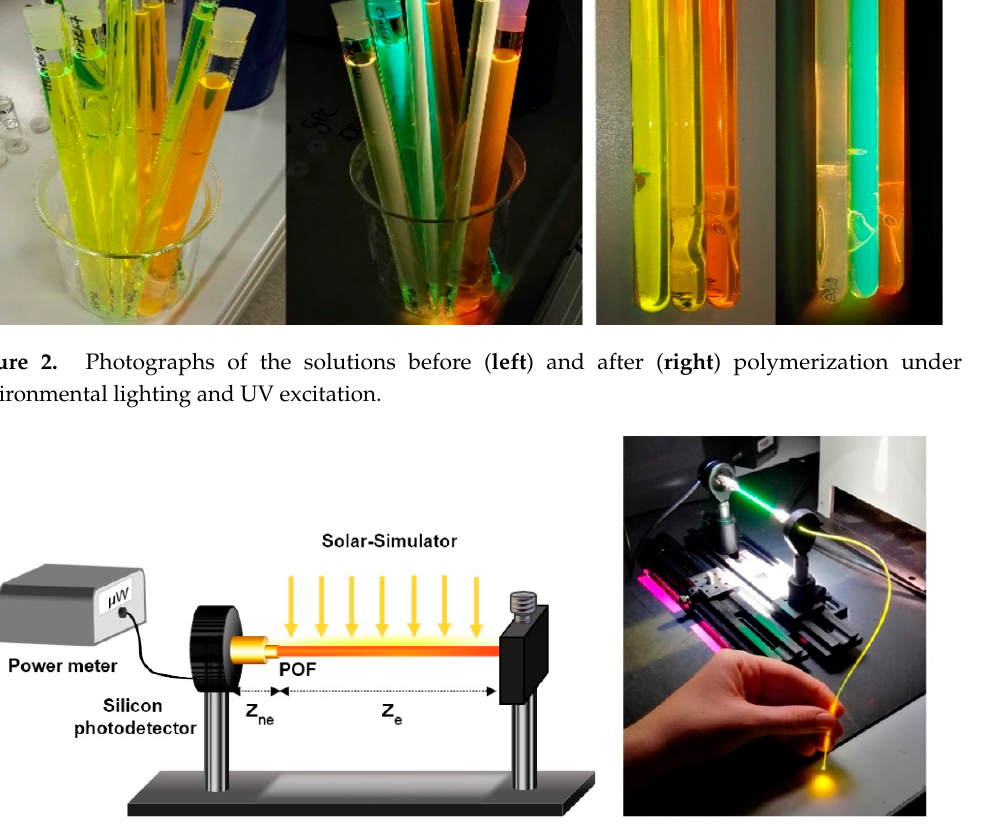
Figure 3. Schematic of the experimental set-up employed for the characterization under solar simulator ( left ). z e represents the illuminated fiber length, and z ne is the non-excited fiber length up to the detector; photograph of one of the fibers in the set-up under solar simulator excitation ( right ).